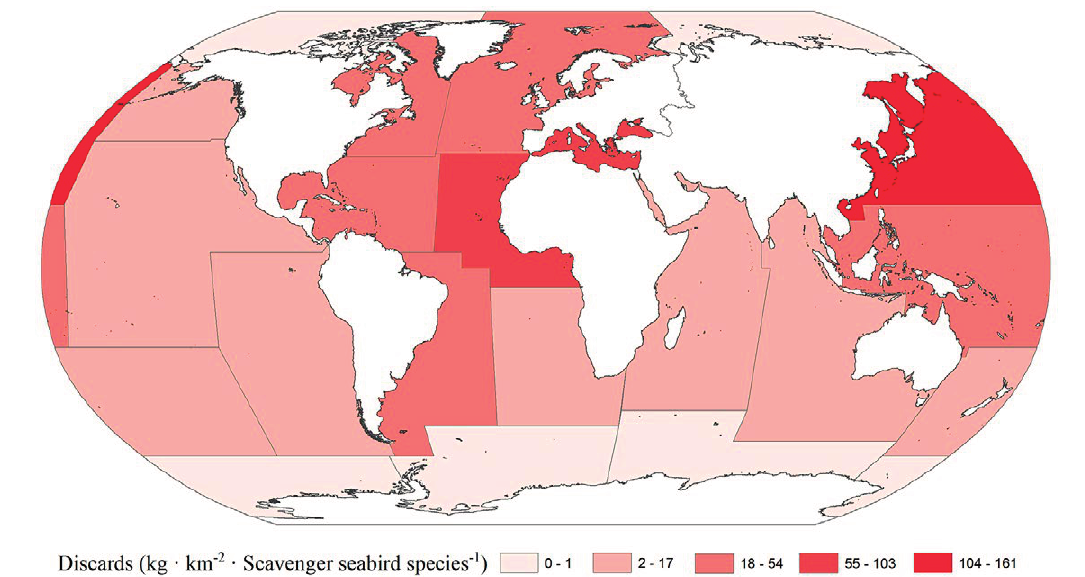
Fig. 1. – Global distribution of fishery discards availability for seabirds in different major FAO fishing areas considering amounts of discards available per unit area and number of scavenger seabird species converging in each